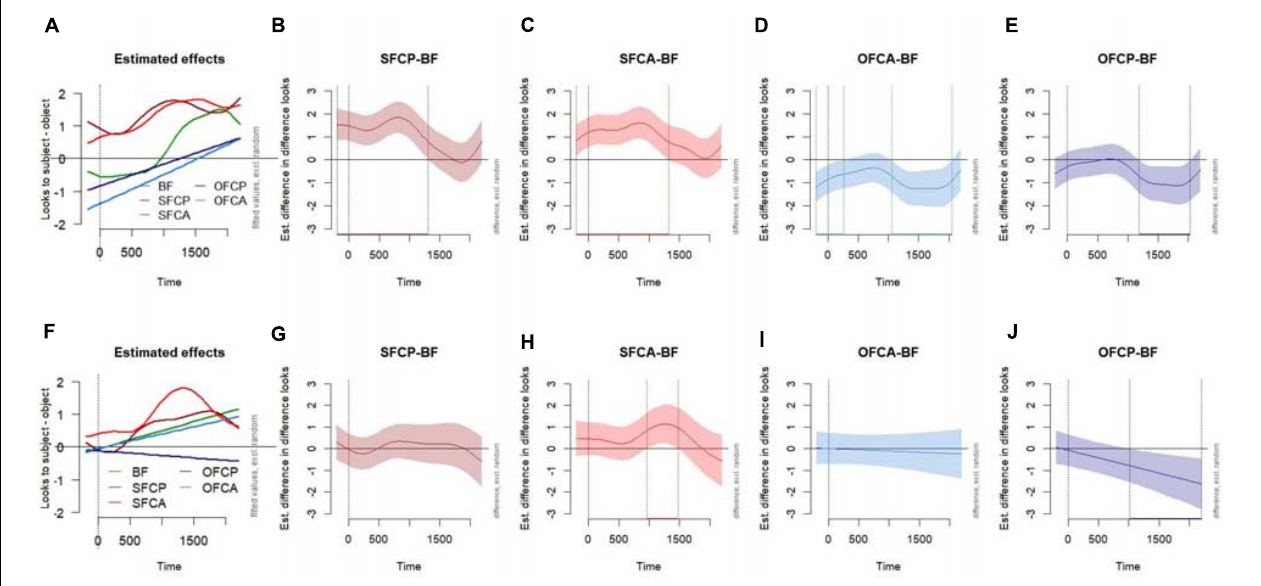
FIGURE 3 | Visualisation of the summed effects derived from the “Main” models of adult (A–E) and 3- to 6-year old (F–J) fixation patterns, with the random effects set to zero. (A,F) Smooth terms for each time by condition term. (B–E,G–J) Difference plots visualising the difference between the broad focus condition with each other condition. The difference plots are coloured consistent with the grand means ( Figure 2 ) and smooth terms plot (A,F) , and have been abbreviated from left to right “SFCP” = subject focus-cleft present (dark red), “SFCA” = subject focus-cleft absent (red), “OFCA” = object focus-cleft absent , (blue), and OFCP = o bject focus-cleft present (navy